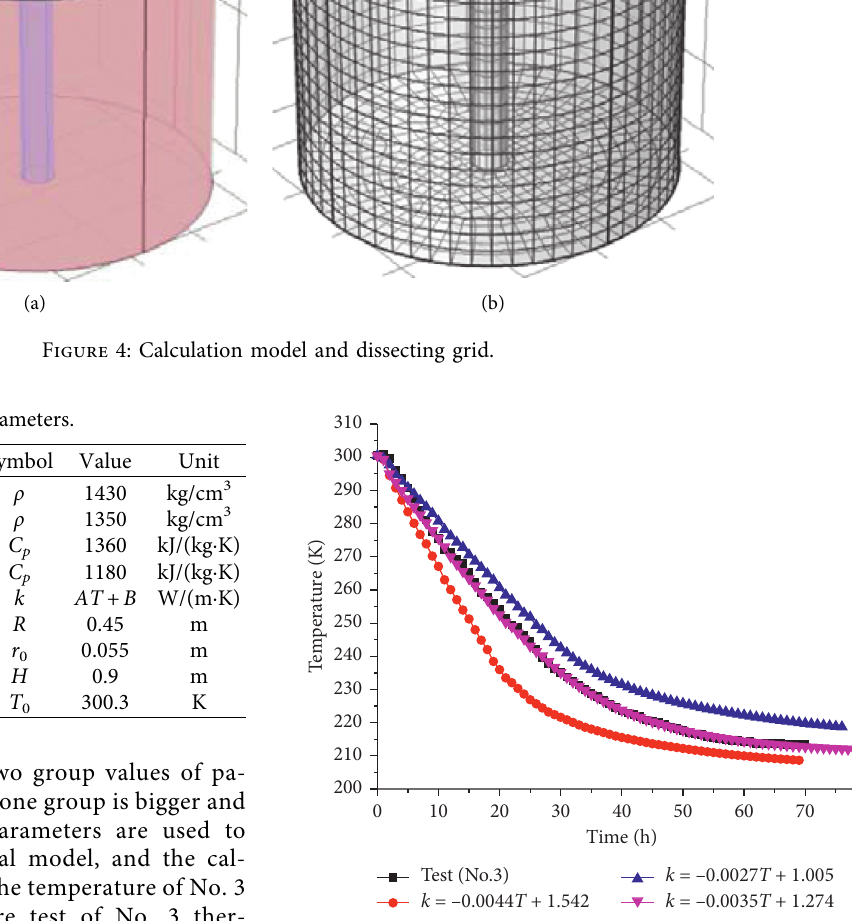
Figure 5: Comparison the calculation results with test